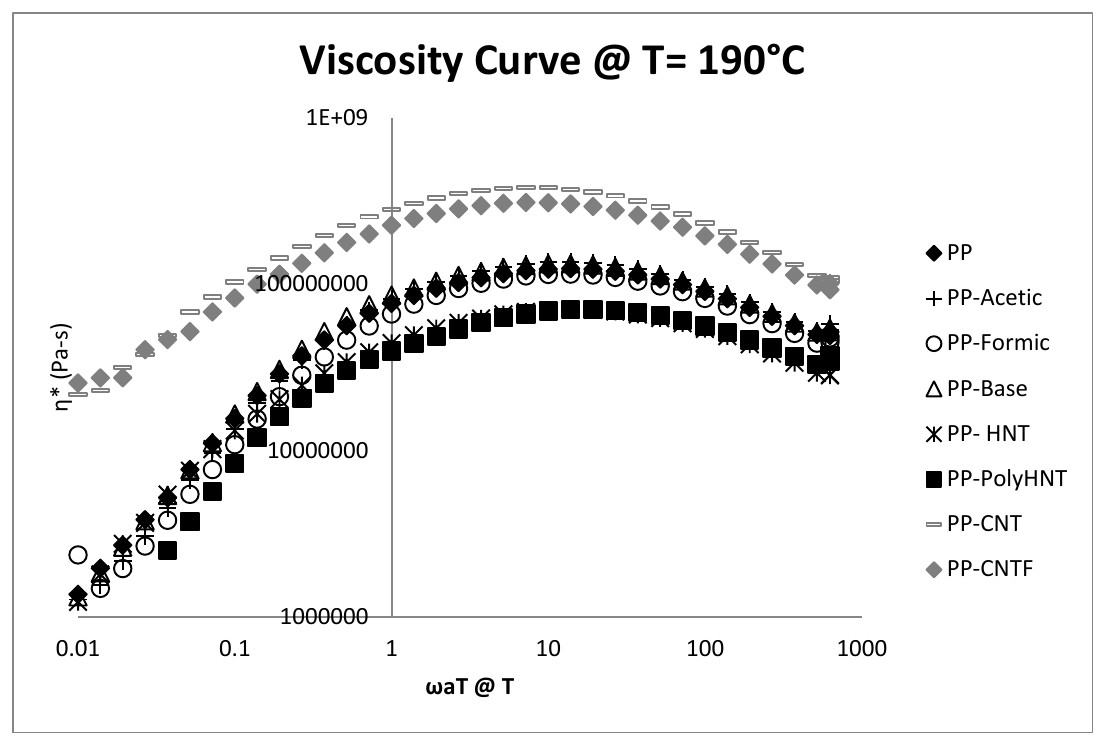
Figure 5. Viscosity curve @ 190 °C for all samples.